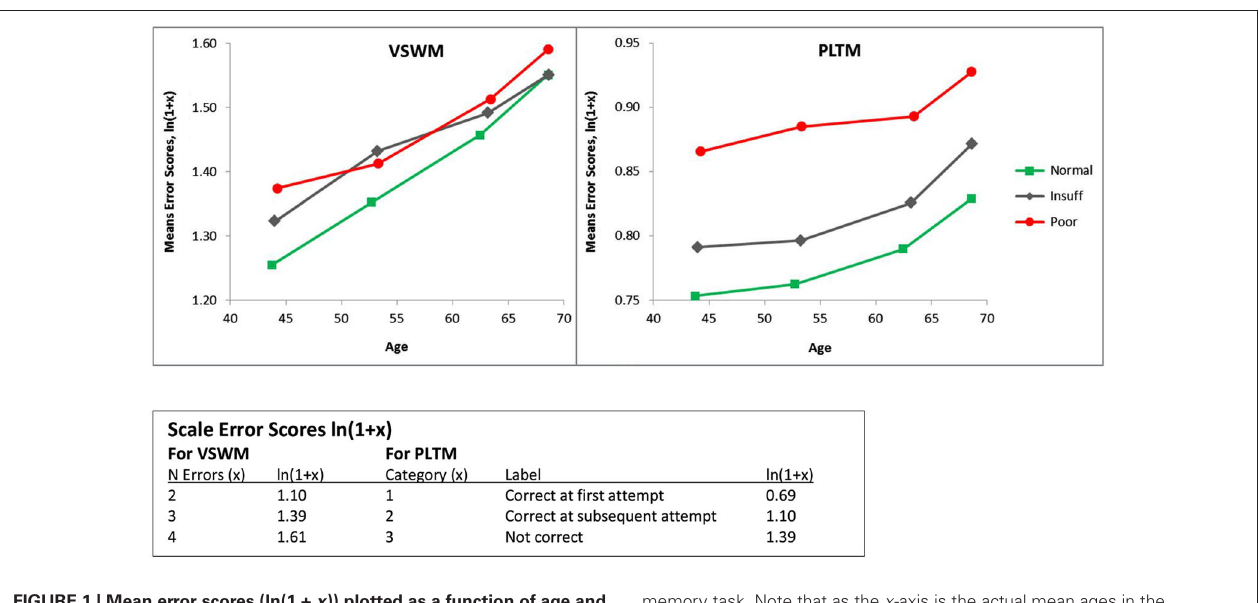
FIGURE 1 | Mean error scores (ln(1 + x )) plotted as a function of age and hearing according to Dawes et al. (2014), called Hear, with categories in SRT dB: Normal = < − 5.5 Insuff = − 5.5 to − 3.5, Poor > − 3.5) . VSWM = The six-pairs picture matching task, PLTM = The prospective